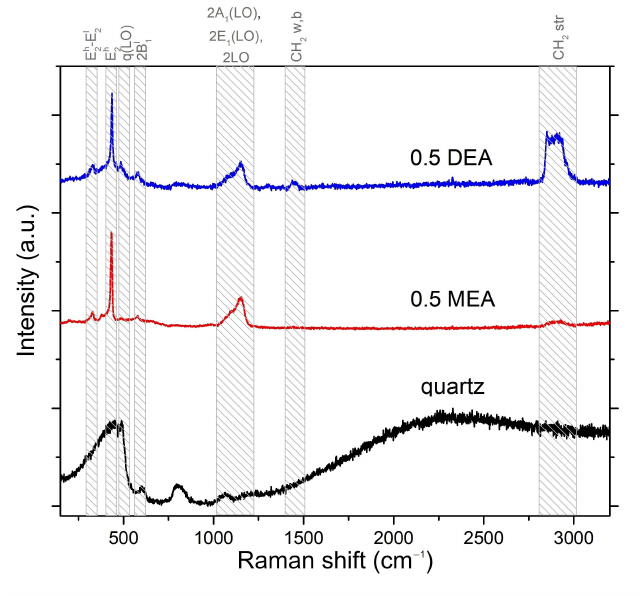
Figure 11. Raman spectra for samples grown on quartz. The grey tags relate to the ZnO and organic bands.